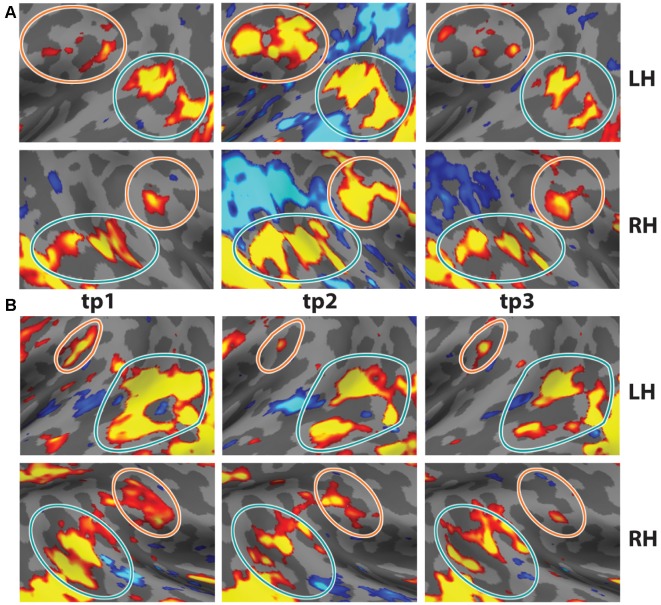
Test-Retest of oddball contrast in two individual subjects. Two subjects were scanned on the task three times. (A) Data from s01 at t = 0, t = 7 months, and t = 19 months. (B) Data from s02 at t = 0, t = 5 months, and t = 11 months (p < 0.01, uncorrected). Note the consistency across time in the anatomical locations. Data from tp1 reflects four runs of the task.